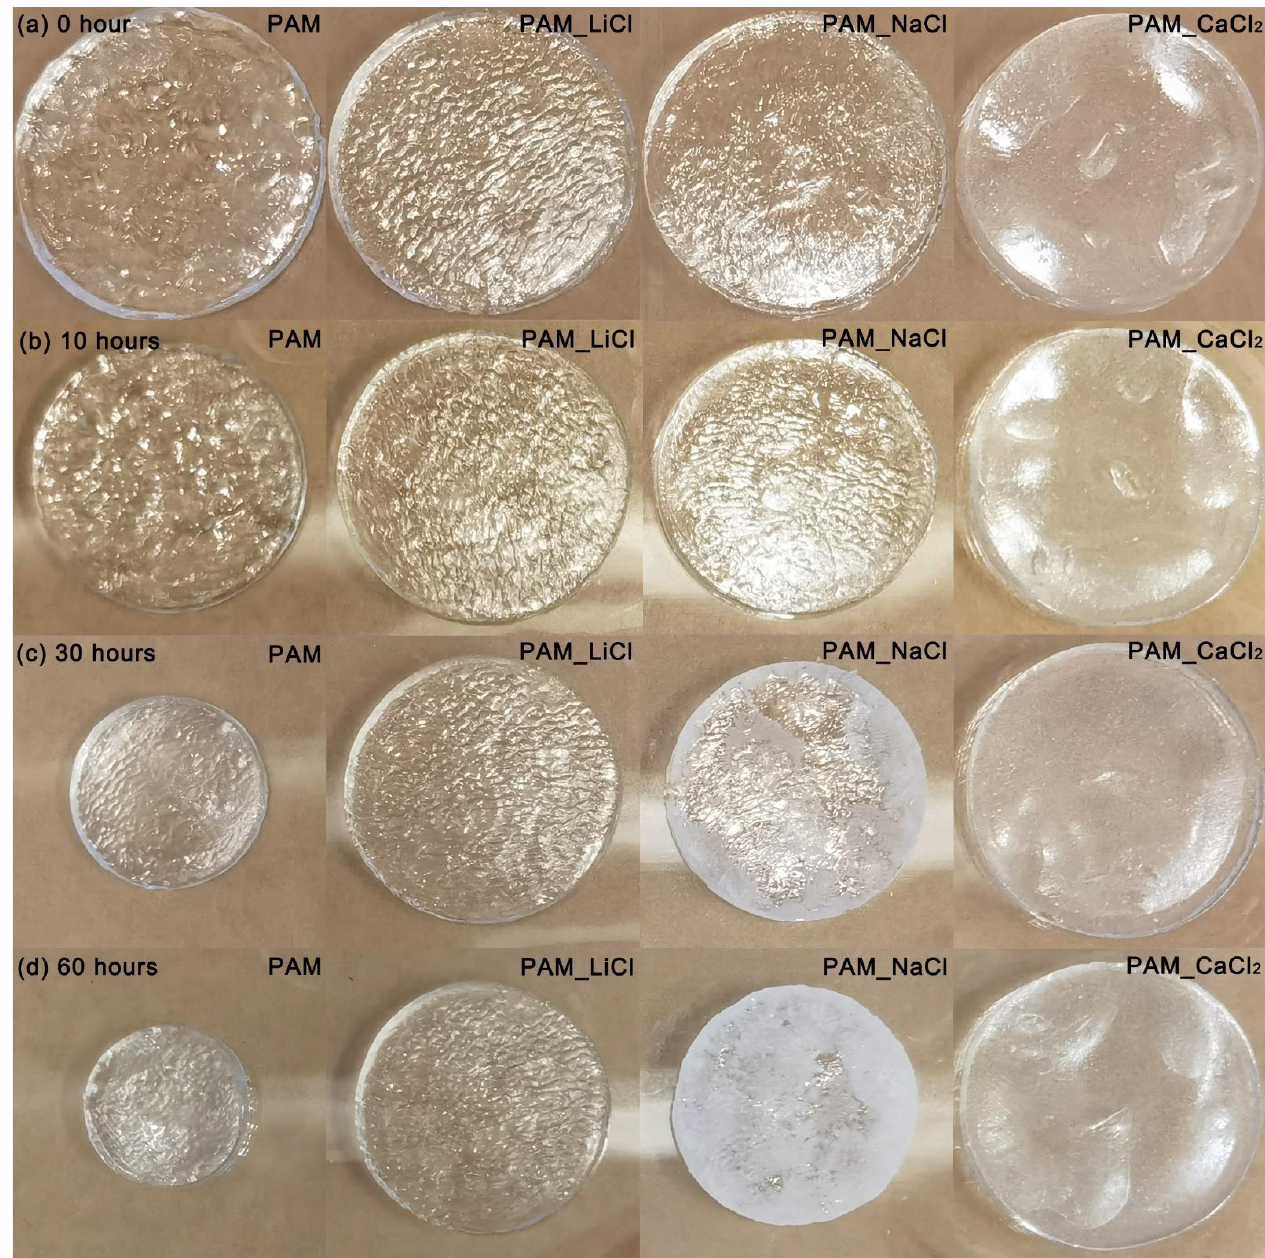
Figure 2. Photos of hydrogel samples kept in an environment at a temperature of 25 °C and relative humidity (RH) of 60% for different periods: ( a ) 0 h; ( b ) 10 h; ( c ) 30 h; ( d ) 60 h. The initial dissolved salt concentration of the hydrogel samples was 4 mol/L. The transparent hydrogel samples were put on anti-adherent films (EFL-GRF-001) in order not to constrain their shrinkage.